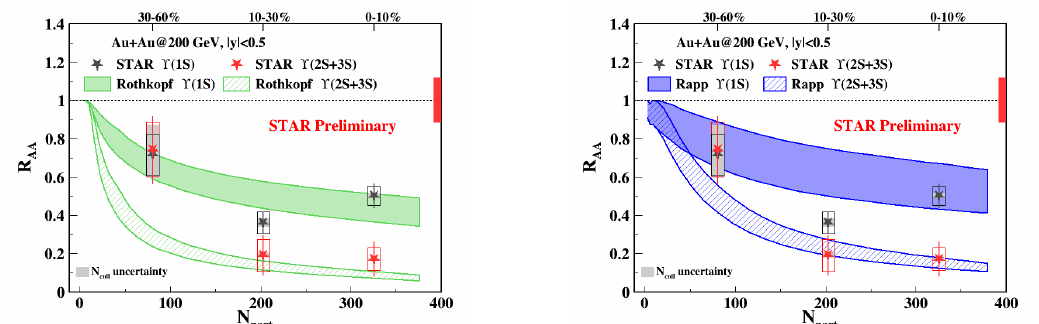
Figure 4. Theoretical predictions for R AA of the Υ (1S) (full area) and the Υ (2S+3S) (dashed area) at √ | y | < 0.5 in Au + Au collisions at s NN = 200 GeV as a function of N part by ( left ) Krouppa, Rothkopf, Strickland [9] and ( right ) Du, He, Rapp [3]. STAR results are plotted as grey and red